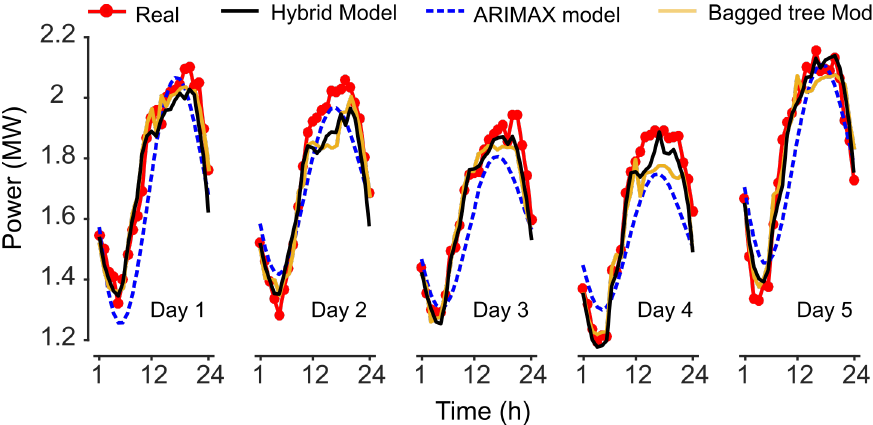
Figure 7. Predicted power demand by the model. Validation of the hybrid intelligent model, the ARIMAX model and the bagged decision tree